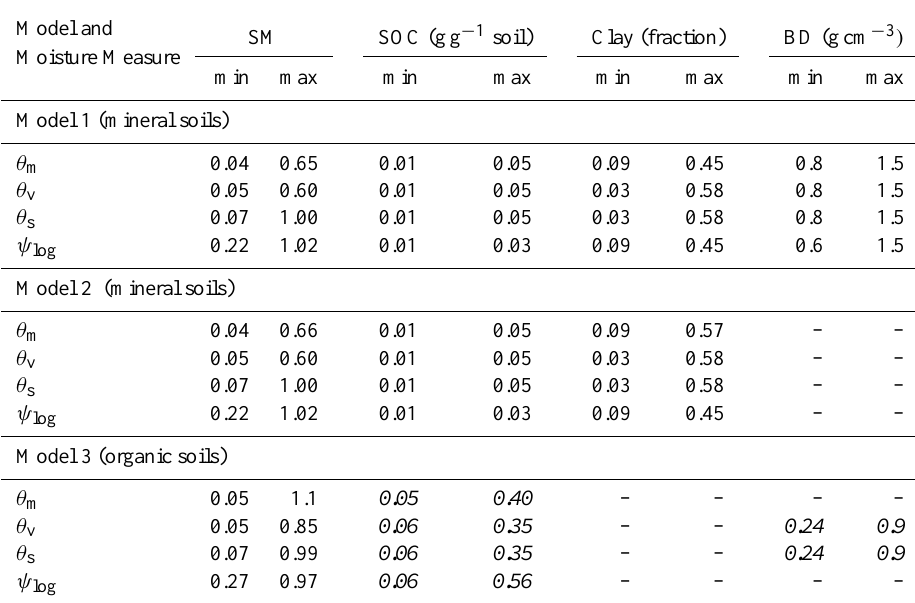
Table 2. Range of values for soil moisture (SM), soil organic carbon (SOC), clay, and bulk density (BD) used to fit linear regression models using different measures of soil moisture. Numbers in italics are for descriptive purposes only since the respective variables were not used in that particular model. θ m is gravimetric moisture (gH 2 O gSoil − 1 ), θ v is volumetric moisture (cm 3 H 2 O cm − 3 ), θ s is relative water